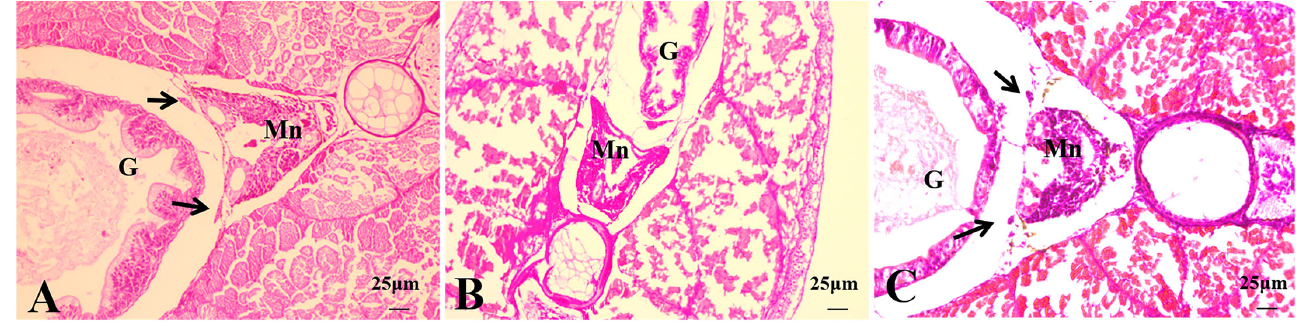
Figure 4. Histological images of gonads of loaches at 22 dph. ( A ): diploid loach; ( B ): hybrid triploid loach without gonads; ( C ): hybrid triploid loach; G: digestive tract; Mn: middle